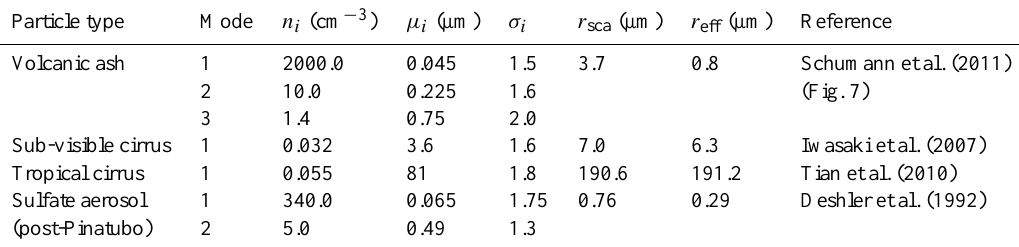
Table 1. Log-normal number size distribution parameters used for the calculation of optical properties shown in Fig. 1. The scattering radius is given at 826cm − 1